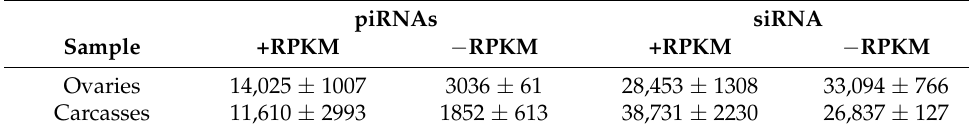
Table 1. RPKM values of strand-specific piRNA and siRNA reads which mapped to CHIKV. piRNAs siRNA Sample